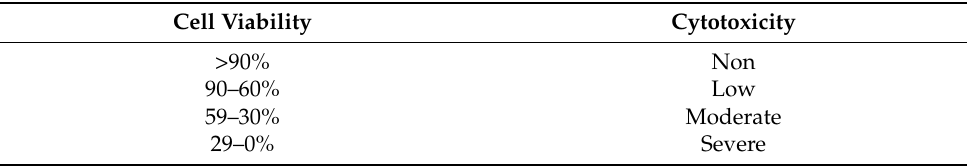
Table 2. Cytotoxicity classification based on the cell viability percentage [37].